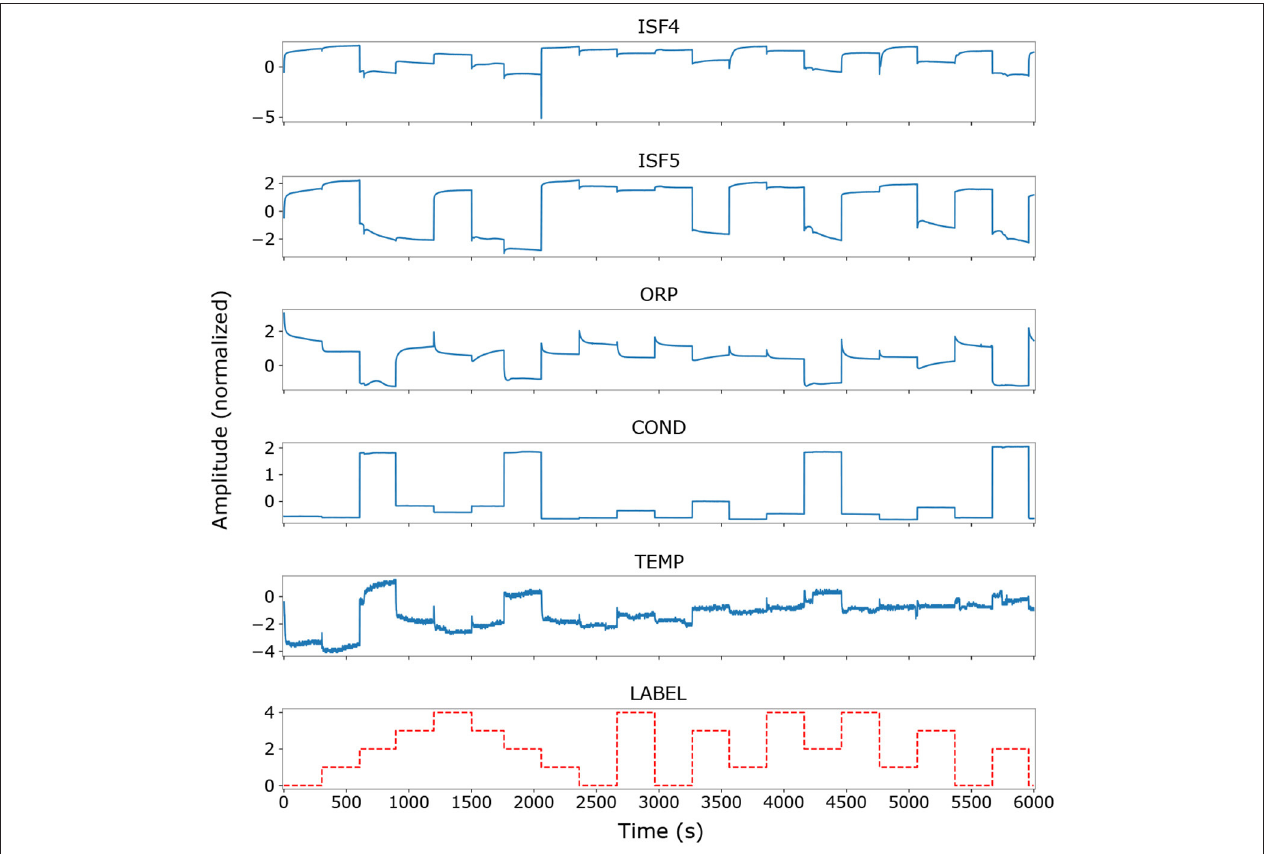
FIGURE 2 | Raw time series data (Z-score-normalized) from the first recording session, showing traces from the Cl − , NO − 3 , redox potential, conductivity and temperature sensors over the first full measurement cycle. The remaining ISFET channels are omitted for clarity. Individual sensor signals and the associated labels are plotted against the sample index (corresponding to seconds of valid measurements). Note the predominance of constant-offset components over transient dynamics in the signals.